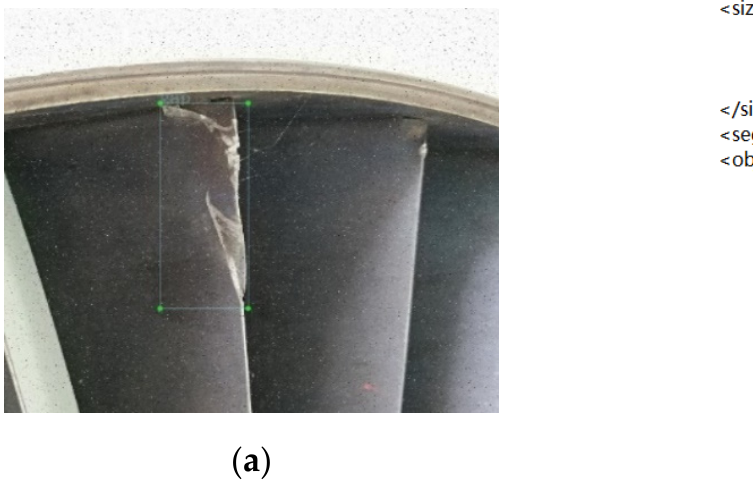
Figure 6. Defect labeling example. ( a ) Labeling box; ( b ) Xml file.